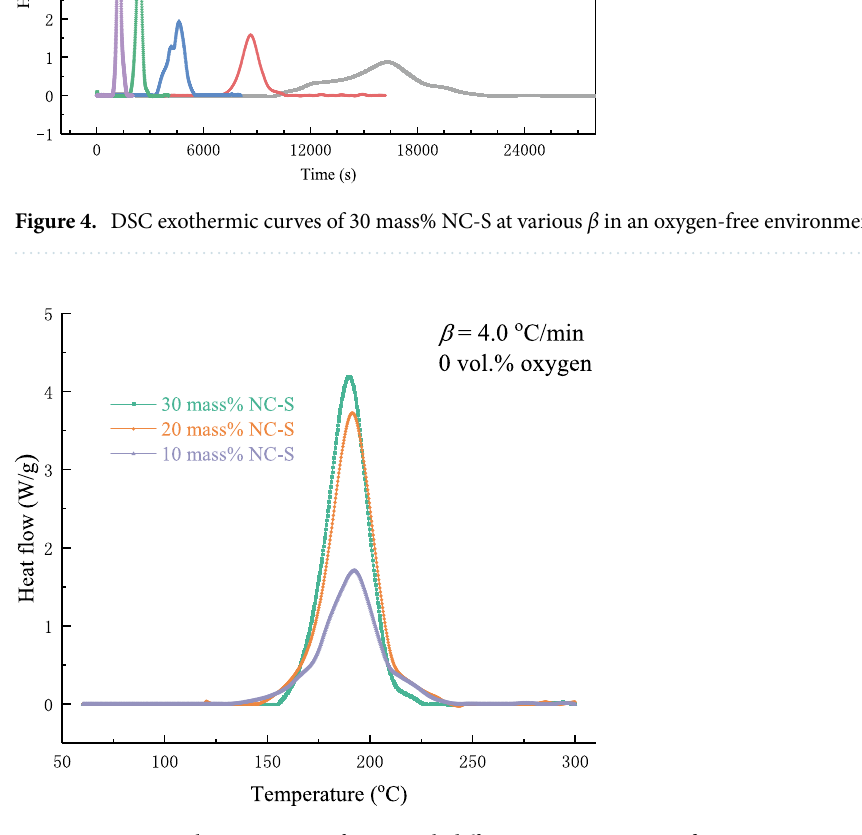
Figure 5. DSC exothermic curves of NC-S with different concentrations at β = 4.0 °C/min in an oxygen-free